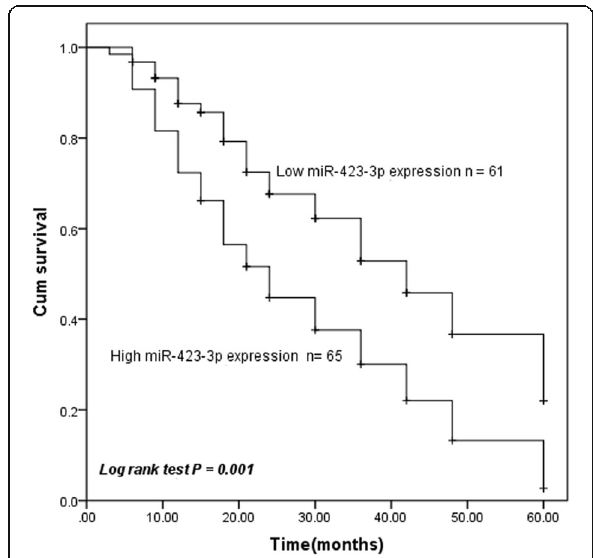
Fig. 2 Upregulation of miR-423-3p correlated with poor prognosis of lung cancer patients according to the result of the Kaplan-Meier method